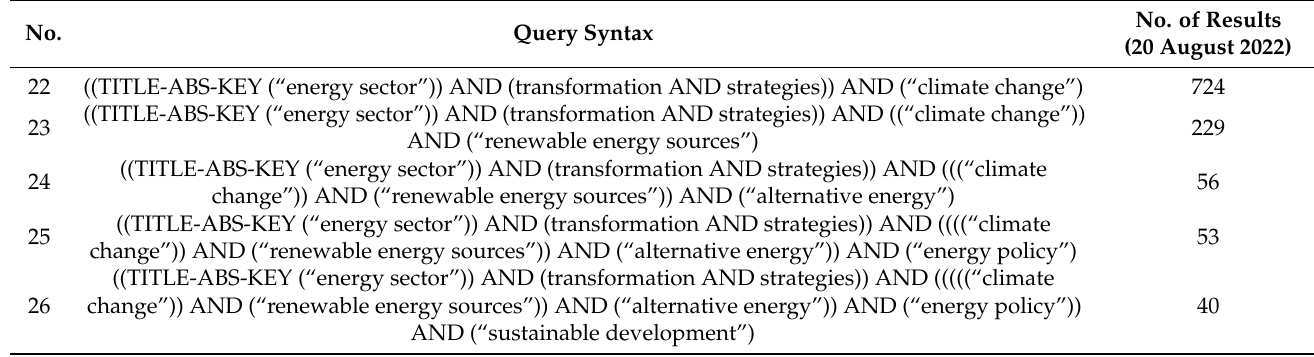
Table 3. Queries developed upon Query 2 from Table 1 used in the Scopus database